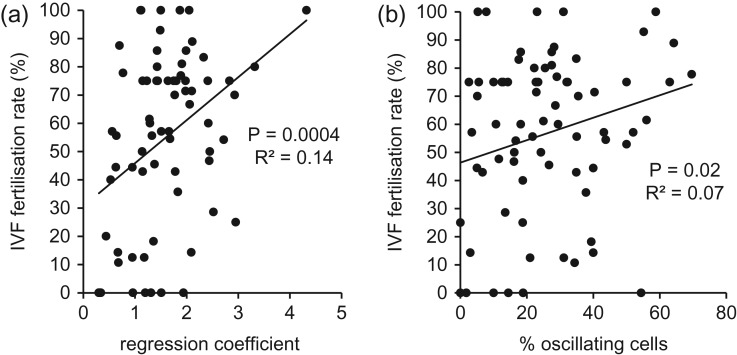
[Ca2+]i signalling and fertilization rate. (a) P4 sensitivity and IVF fertilization rate. X-axis is regression coefficient calculated for the relationship between single cell resting fluorescence and P4-induced fluorescence for each sample. Y-axis vale is fertilization rate for each sample. Data from 62 IVF(+ve) and 8 IVF-FF samples. (b) Induction of [Ca2+]i oscillations by P4 and IVF fertilization rate. Plot shows relationship between proportion of cells in which oscillations were induced by treatment with P4 (3.6 μM) and the fertilization rate (%) achieved at IVF with that sample. Data from 62 IVF(+ve) and 8 IVF-FF samples.